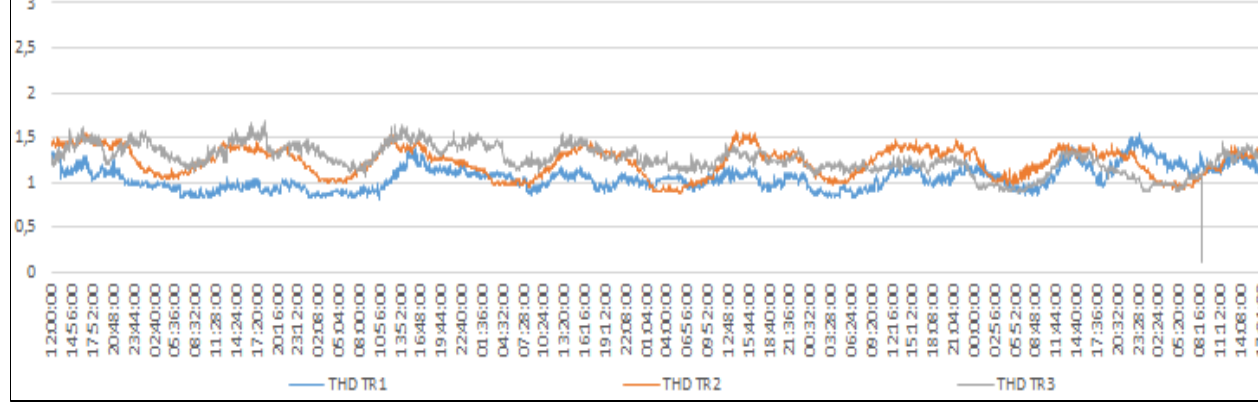
Figure 6: THD voltage phase “b” indicator graphic.